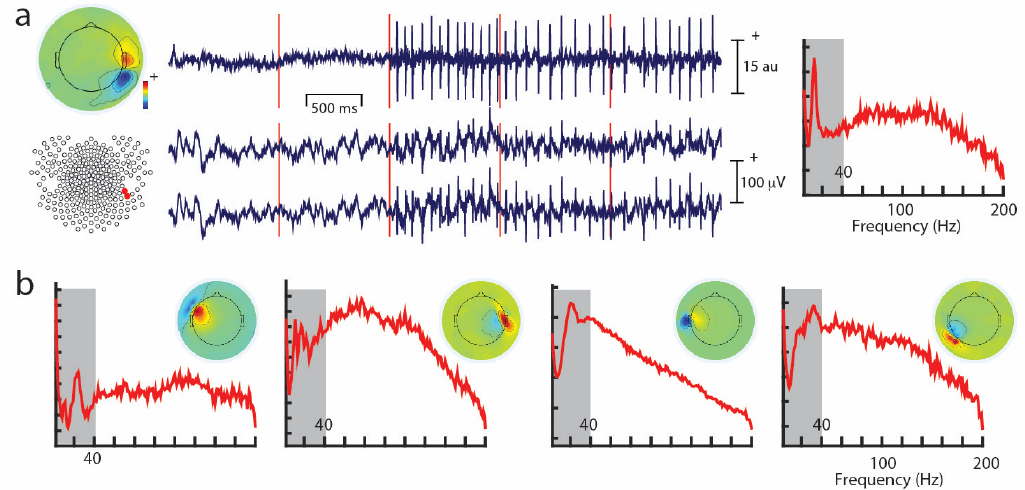
Figure 4. Muscle unit spiking artifact. ( a ) A topographic map from Independent Component Analysis (ICA, left panel, top) and the associated scalp EEG electrodes (bottom left, red circles) overlying a muscle unit. The muscle unit’s ICA time course (middle panel, Trace 1) and corresponding EEG data (Traces 2 and 3, with red vertical lines separating data epochs are shown). The spiking of the muscle unit appears in the third epoch and is seen above some residual muscle activity. The muscle unit’s spikes can be clearly seen in the EEG signal and coincide temporally with spikes in the ICA time courses. The associated logarithmic power spectrum (right panel) shows a prolonged tail of EMG activity out to 200 Hz, but also has a prominent peak in the EEG frequency range (0–40 Hz, gray shading) caused by the spiking of the muscle unit. a.u. = arbitrary units, µ V = microvolts. ( b ) Examples of spatial distributions EMG ICA components with their associated power spectra. All show prolonged tails up to 200 Hz with different peaks, some of which clearly occur in the EEG/MEG frequency band (0–40-Hz range, gray shading) in all plots. Peaks in the alpha and beta ranges are caused by the spiking behavior of the muscle units.